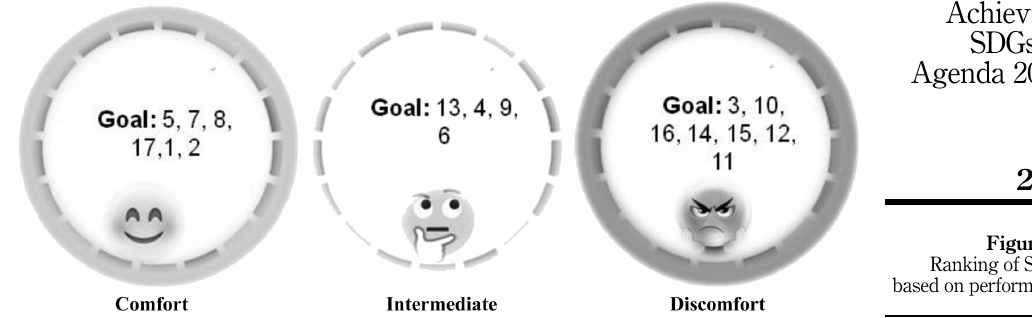
Figure 4. Ranking of